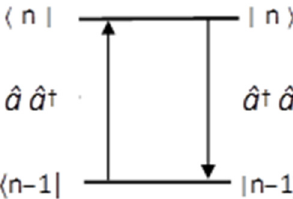
Figure 1. An illustration of the dynamic and coherent two-component number states.